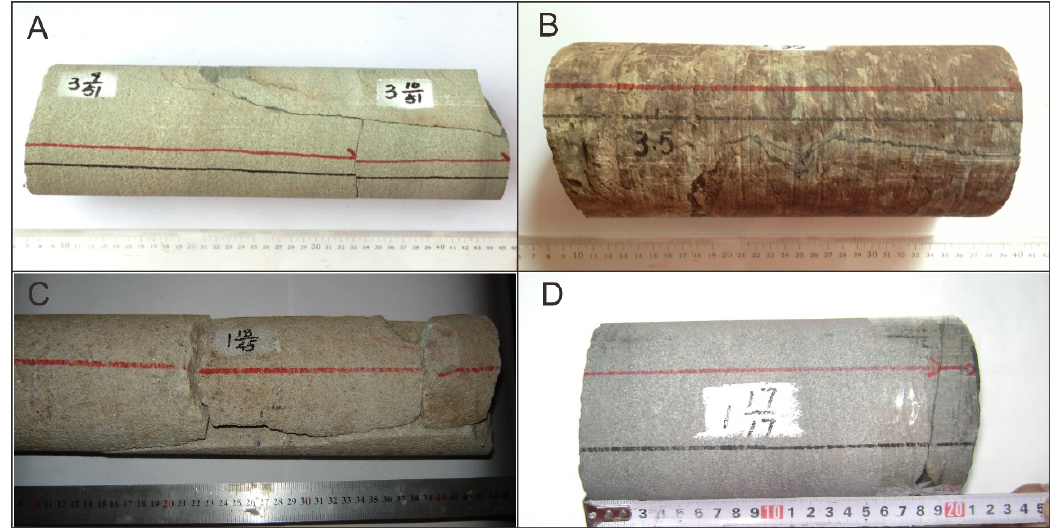
Figure 12. Core photos showing the characteristics of fractures in the Lower Shihezi Fm. ( A ) Well J107, 3193.26–3193.61 m, medium-grained sandstone; ( B ) Well J107, 3137.26–3137.50 m, mudstone; ( C ) Well J62, 3457.41–3457.85 m, pebbly coarse-grained sandstone; ( D ) Well J91, 2953.96–2954.15 m, fine-grained sandstone.